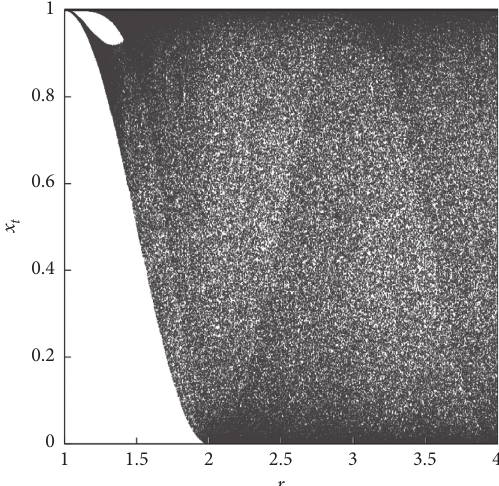
Figure 4: Bifurcation diagram of map equation (11) as a function of the parameter r